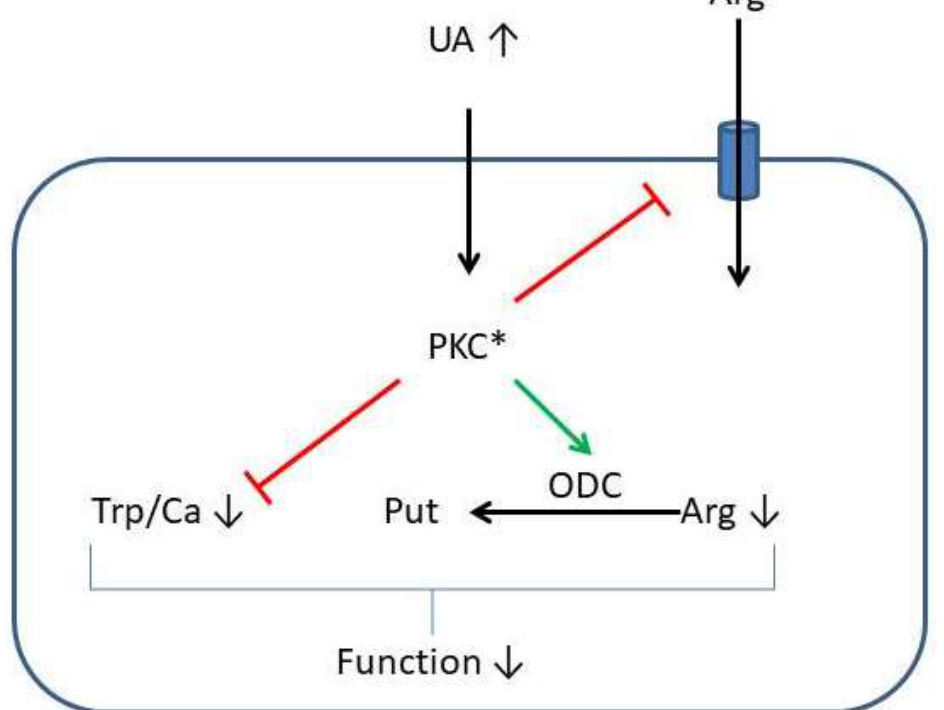
Figure 9. Summary of the findings of this study and schematic overview how these data may explain the long-term effect of high concentrations of UA on the cell shortening (function) of cardiomyocytes (see Figure 1). High concentrations of extracellular UA (UA ↑ ) activate PKC-dependent pathways (PKC*), as suggested from the experiments with a PKC-inhibitor (Figure 5B). Subsequently, arginine uptake is affected (see Figure 4), ODC is induced (see Figure 2), and the arginine metabolism altered (Figures 3 and 4). Function is impaired in the presence of high intracellular calcium (see Figure 6).